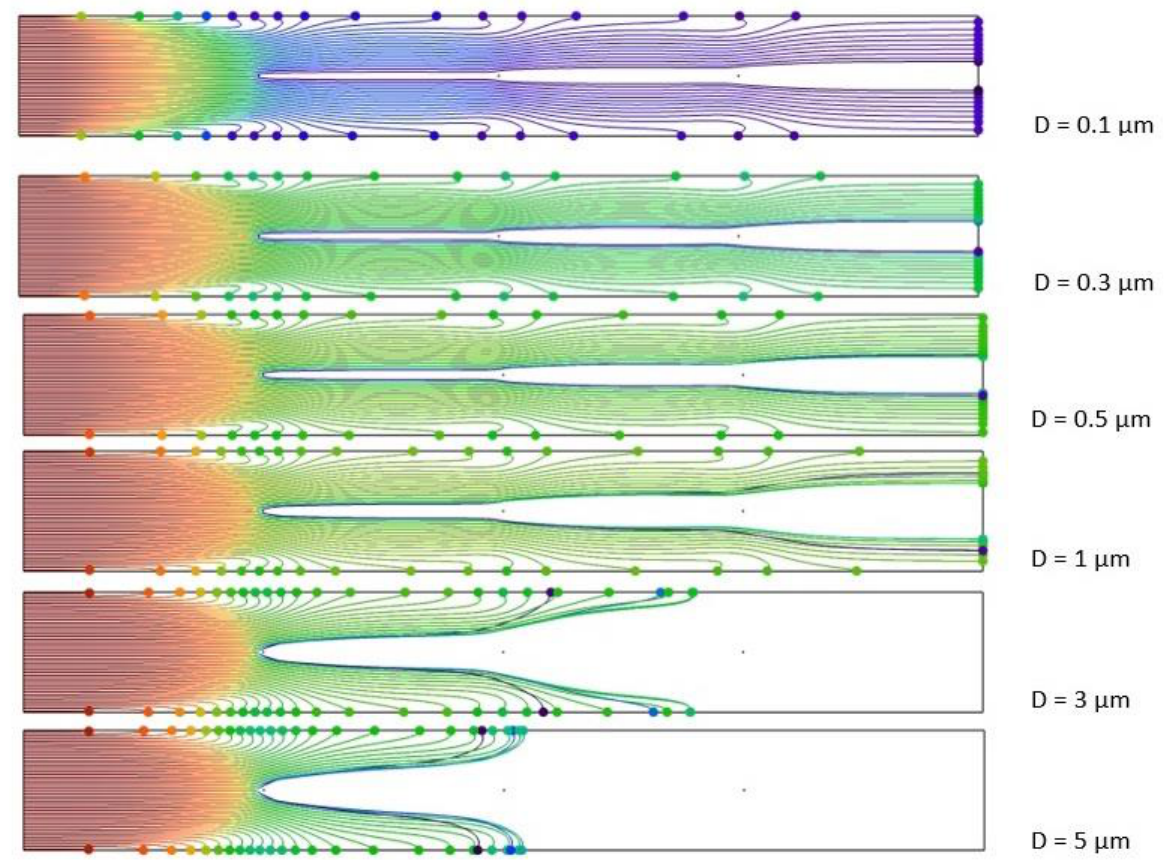
Figure 16. Aerosol trajectories through the ESS channel for aerosols with uniform diameters of, respectively, 0.1 µm, 0.3 µm, 0.5 µm, 1 µm, 3 µm, and 5 µm at V = −30 kV.